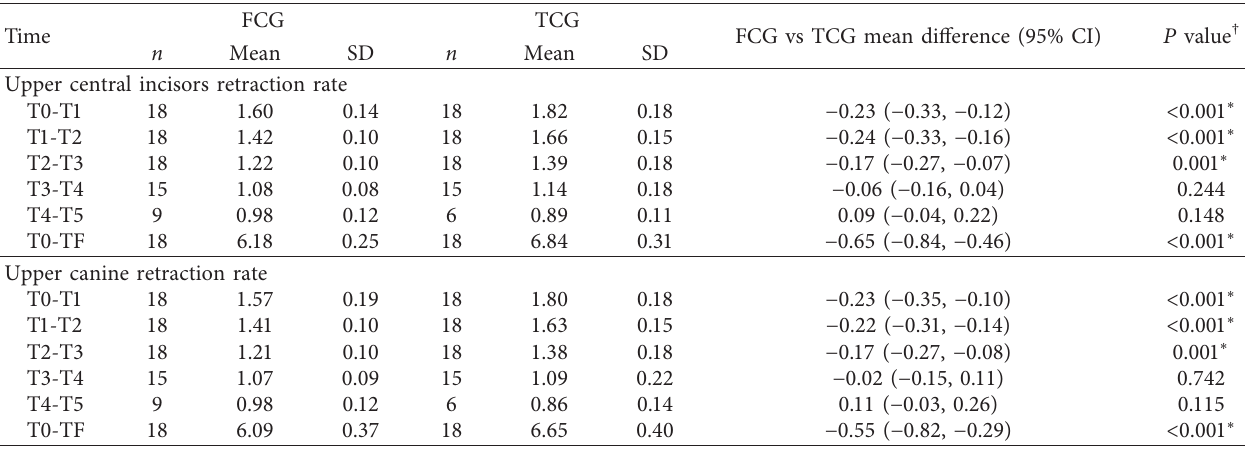
Table 2: Descriptive statistics of the en-masse retraction rate (mm/month) as well as the P values of significance tests. Time Upper central incisors retraction rate